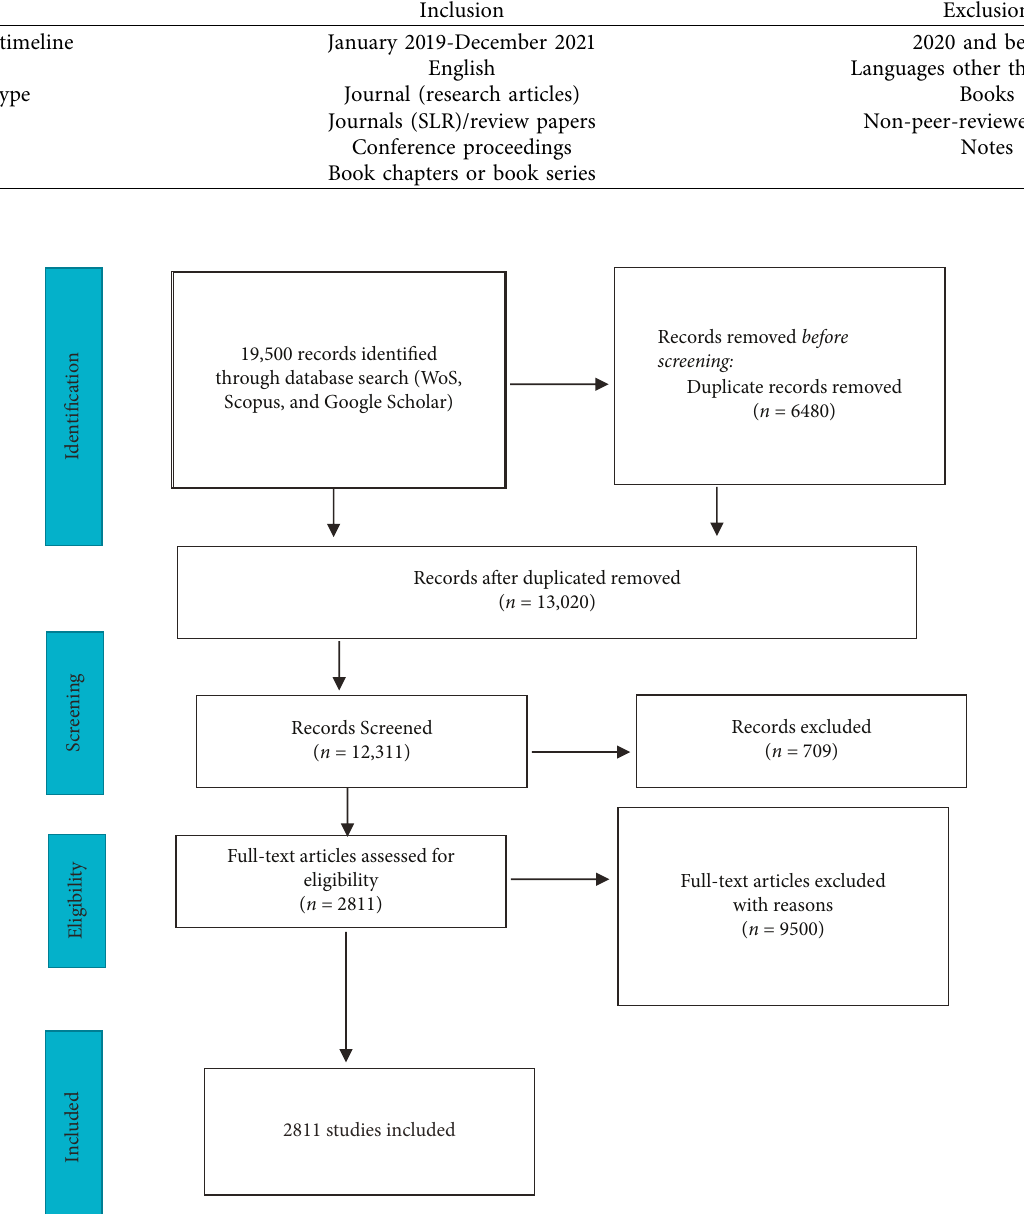
Figure 33: PRISMA flow chart for systematic literature review.